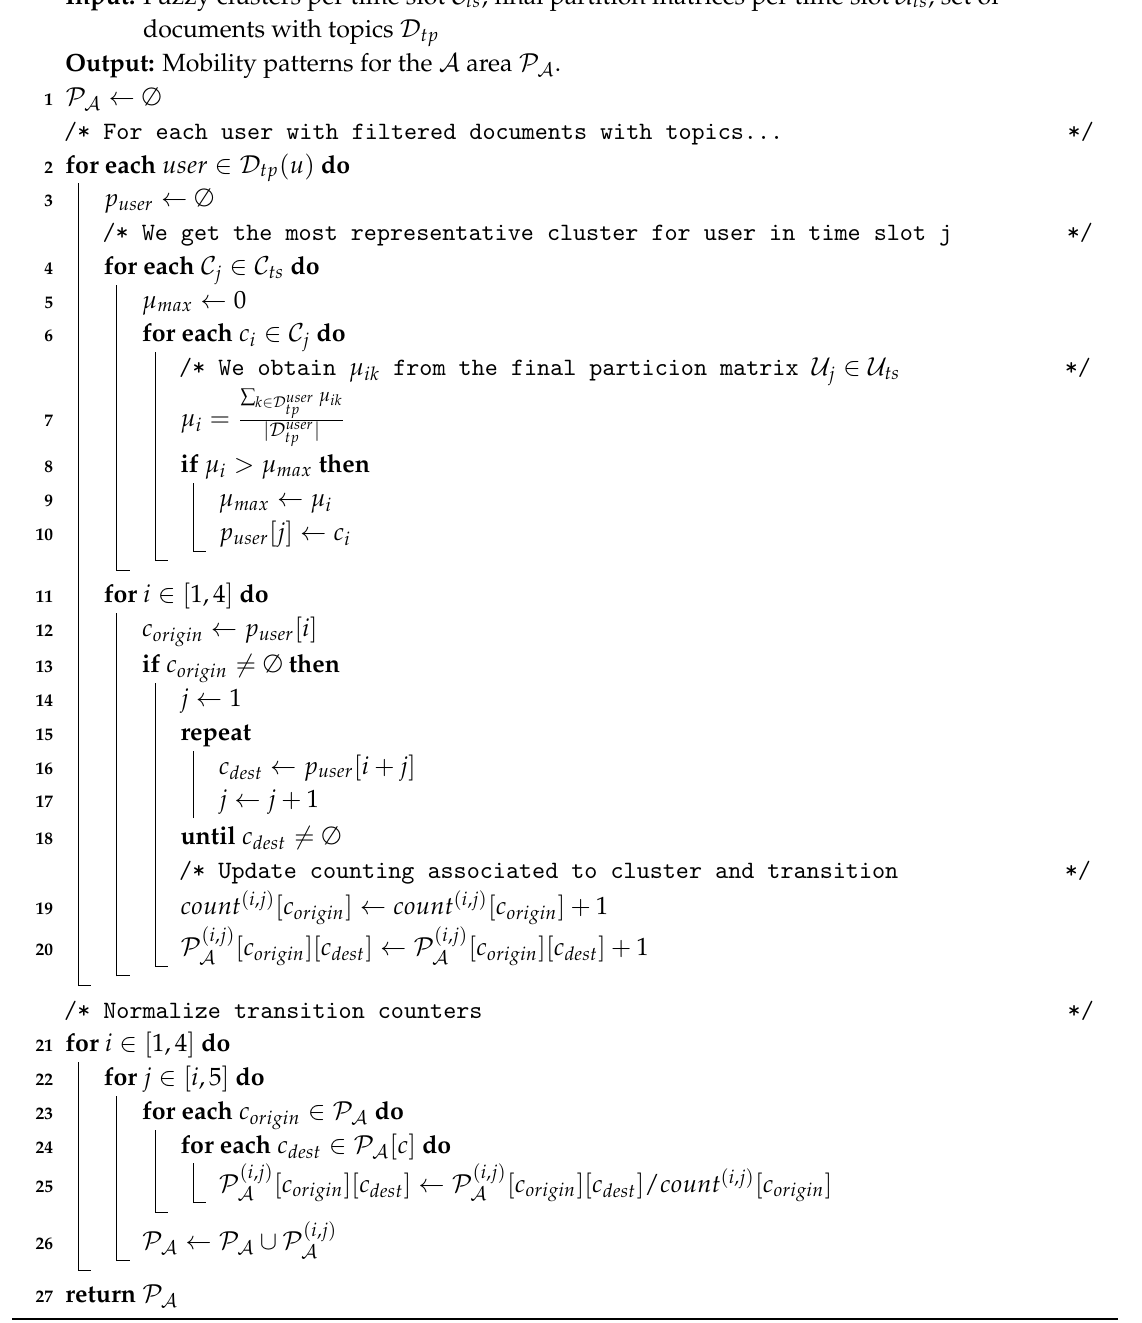
Algorithm 2: Pattern discovery